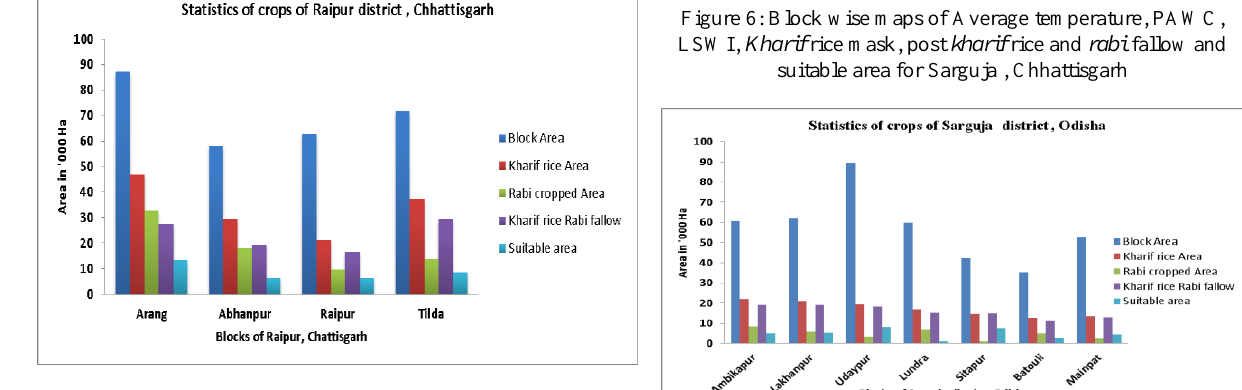
Figure 4: Block wise statistics in Raipur district, Chhattisgarh Surguja (Chhattisgarh)